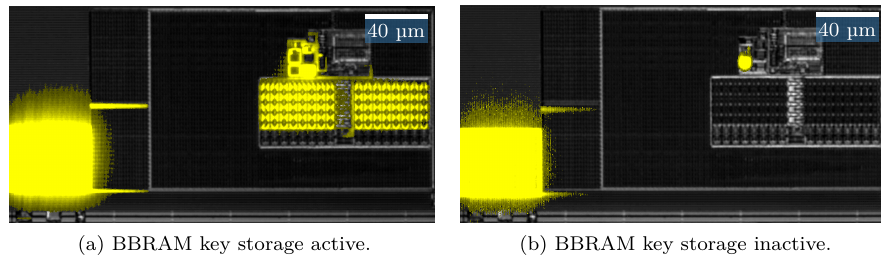
Figure 9: TLS measurements for key memory localization using the 50x lens.